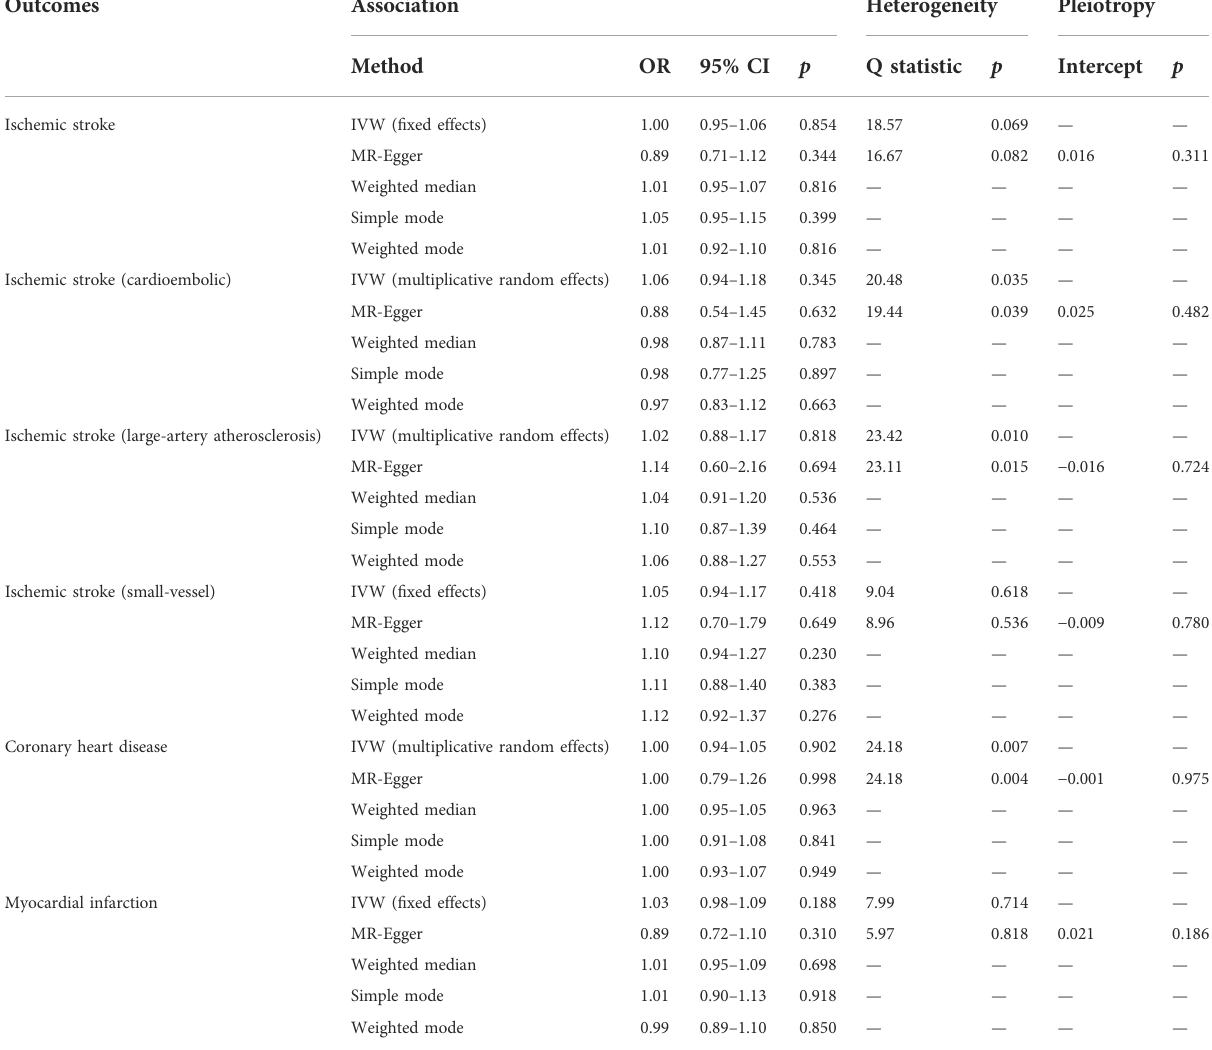
TABLE 1 Mendelian randomization for the association of atopic dermatitis with ischemic stroke and coronary heart disease.